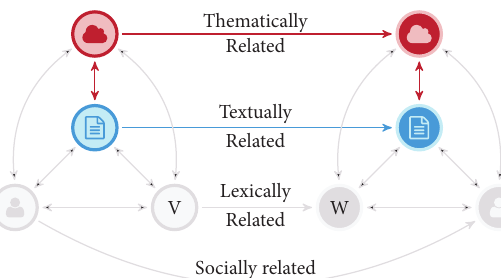
Figure 3: Schematic depiction of the informational sources of linking topics (red vertices) in text topic networks as a function of the textual relatedness of two texts (blue vertices) (belonging to layer L1 of a corresponding LMN—see Definition 1). Bidirectional red arcs denote arcs of the corresponding margin layers: in the present case, this concerns the relation between texts and topics (see below). Relations of thematic relatedness are inferred in this example (see Definition 3). Gray nodes and arcs indicate unconsidered sources of evidence.